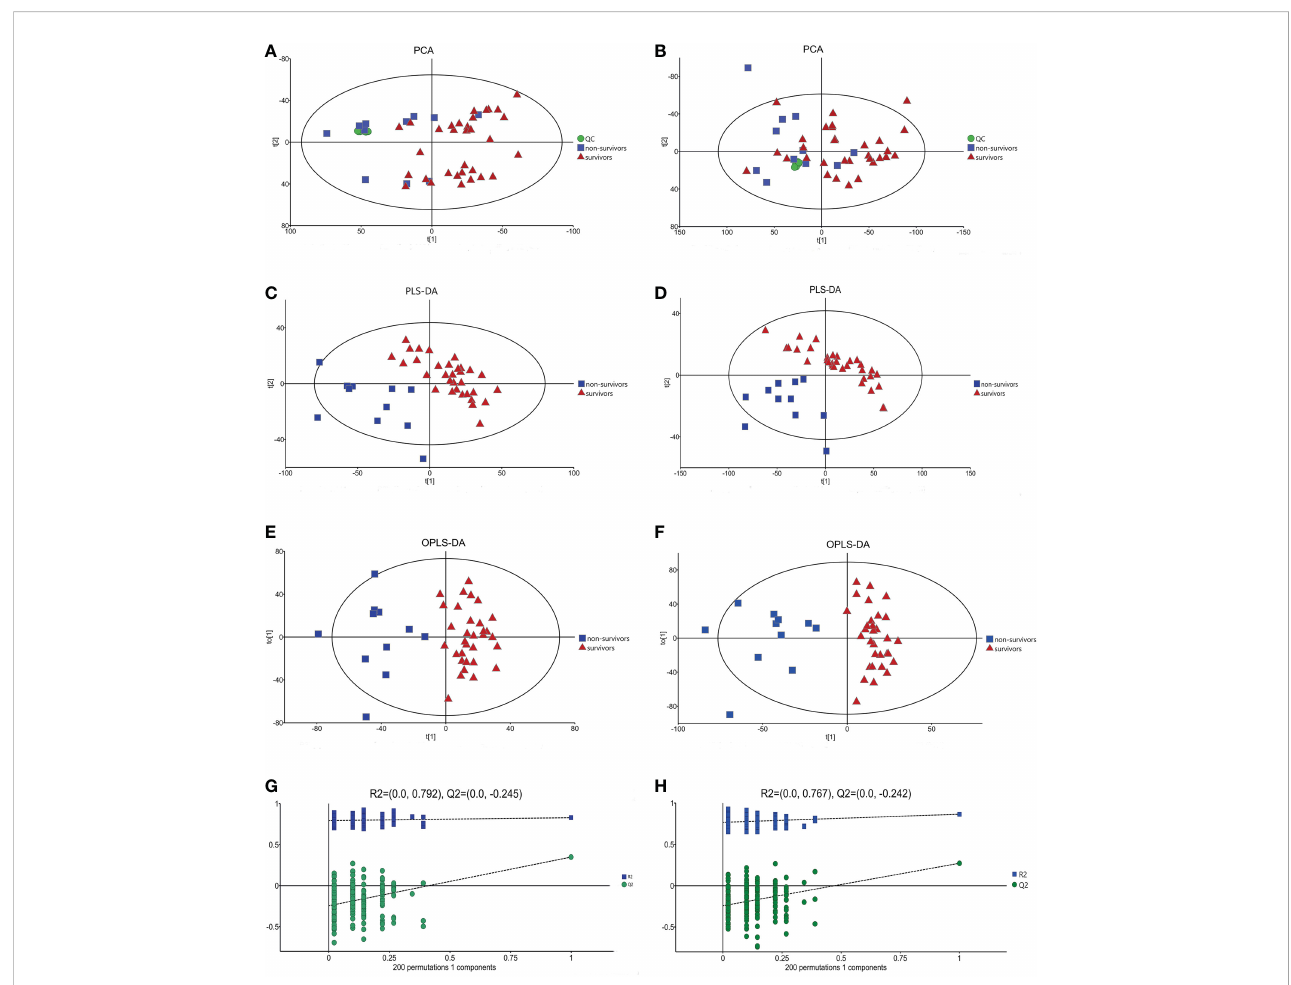
FIGURE 5 The multidimensional results in positive and negative ionization between survivors and non-surviviors of cardiac dysfunction group. (A) PCA score plot in positive ionization mode [R 2 X (cum) = 0.497, Q 2 (cum) = 0.401]. (B) PCA score plot in negative ionization mode [R 2 X (cum) = 0.507, Q 2 (cum) = 0.369]. (C) PLS-DA score plot in positive ionization mode [R 2 X (cum) = 0.409, R 2 Y (cum) = 0.787 Q 2 (cum) = 0.582]. (D) PLS-DA score plot in negative ionization mode [R 2 X(cum) = 0.447, R 2 Y(cum) = 0.795, Q 2 (cum) = 0.576]. (E) OPLS-DA score plot in positive ionization mode [R 2 X (cum) = 0.409, R 2 Y (cum) = 0.787 Q 2 (cum) = 0.483]. (F) OPLS-DA score plot in negative ionization mode [R 2 X(cum) = 0.447, R 2 Y(cum) = 0.795, Q 2 (cum) = 0.462]. (G) Permutation test in positive ionization mode(R 2 = 0.792, Q 2 = -0.245). (H) Permutation test in negative ionization mode(R 2 = 0.767, Q 2 =